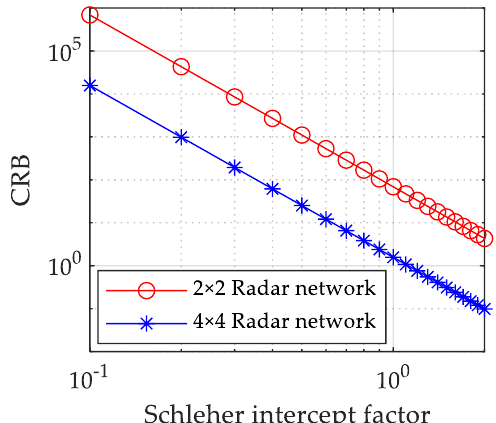
Figure 3. Relation curve between CRB and Schleher Interception Factor under different radar network structures.